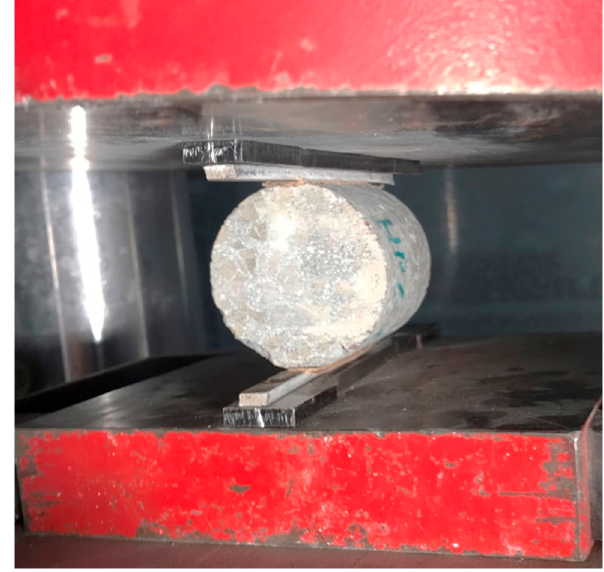
Figure 2. Test scheme for concrete—tension by splitting.